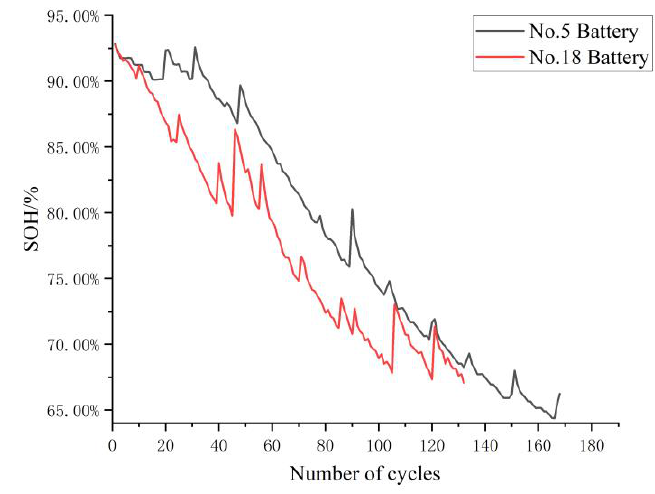
Figure 3. Change curve of SOH at different discharge cut-off voltages.